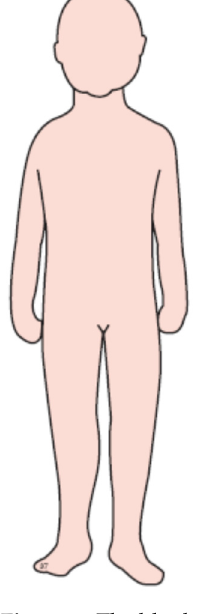
Figure 3. The blank body outline [14].